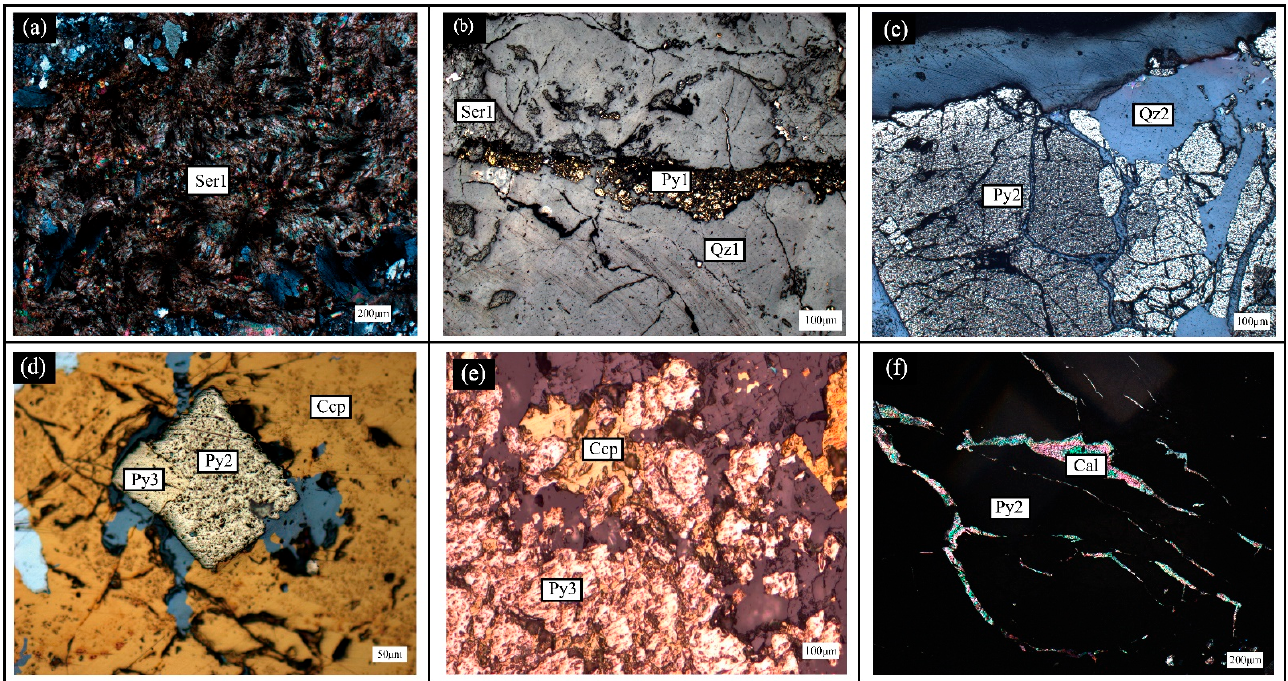
Figure 4. Ore microscope features of Fang’an gold deposit: ( a ) sericitization; ( b ) pyrites occurring in vein-filling form; ( c ) stockwork vein fracture in massive pyrite; ( d ) two-stage pyrite; ( e ) intergrown chalcopyrite in pyrite; ( f ) carbonation. Ccp—chalcopyrite; Py—pyrite; Qz—quartz; Ser—sercite; Cal—calcite.